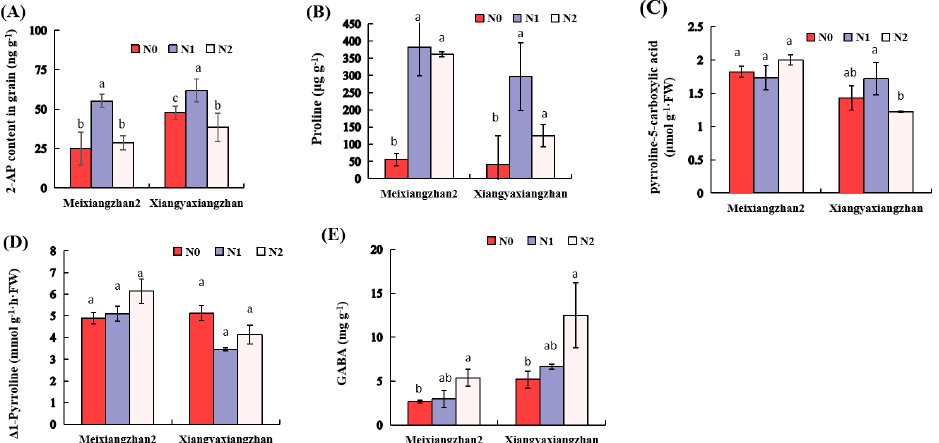
Figure 3. The effect of N treatments on the ( A ) 2AP, ( B ) proline, ( C ) P5C, ( D ) Δ 1-Pyrroline and ( E ) GABA contents in Meixinagzhan2 and Xiangyaxiangzhan. Data are means (±SE), n = 3. The different letter above the column indicates difference at p < 0.05 by LSD tests. Capped bars represent standard errors.